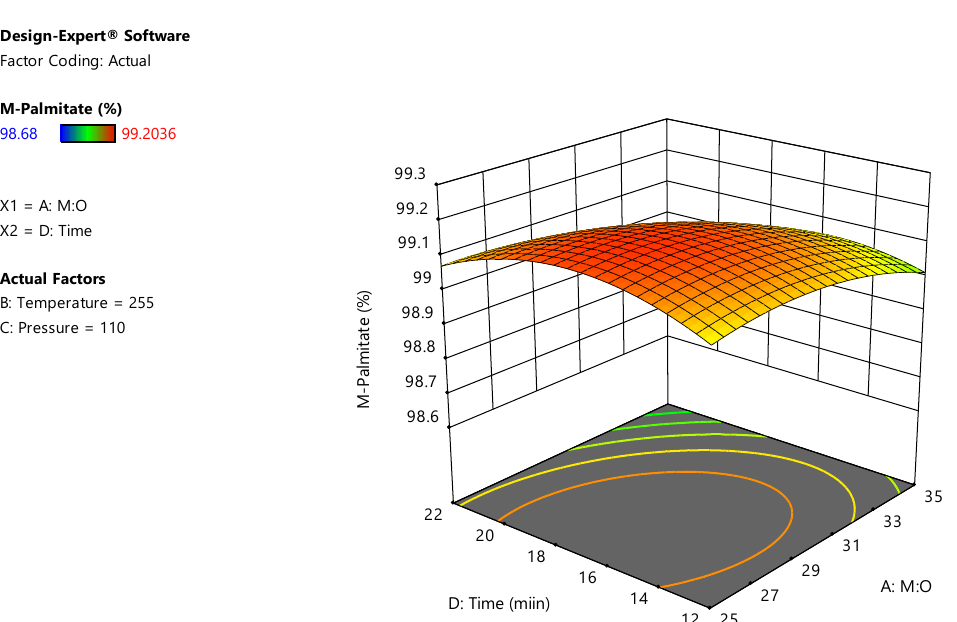
Figure A4. Response surface a for the effect of M:O molar ratio and reaction time on the yield of methyl-palmitate.